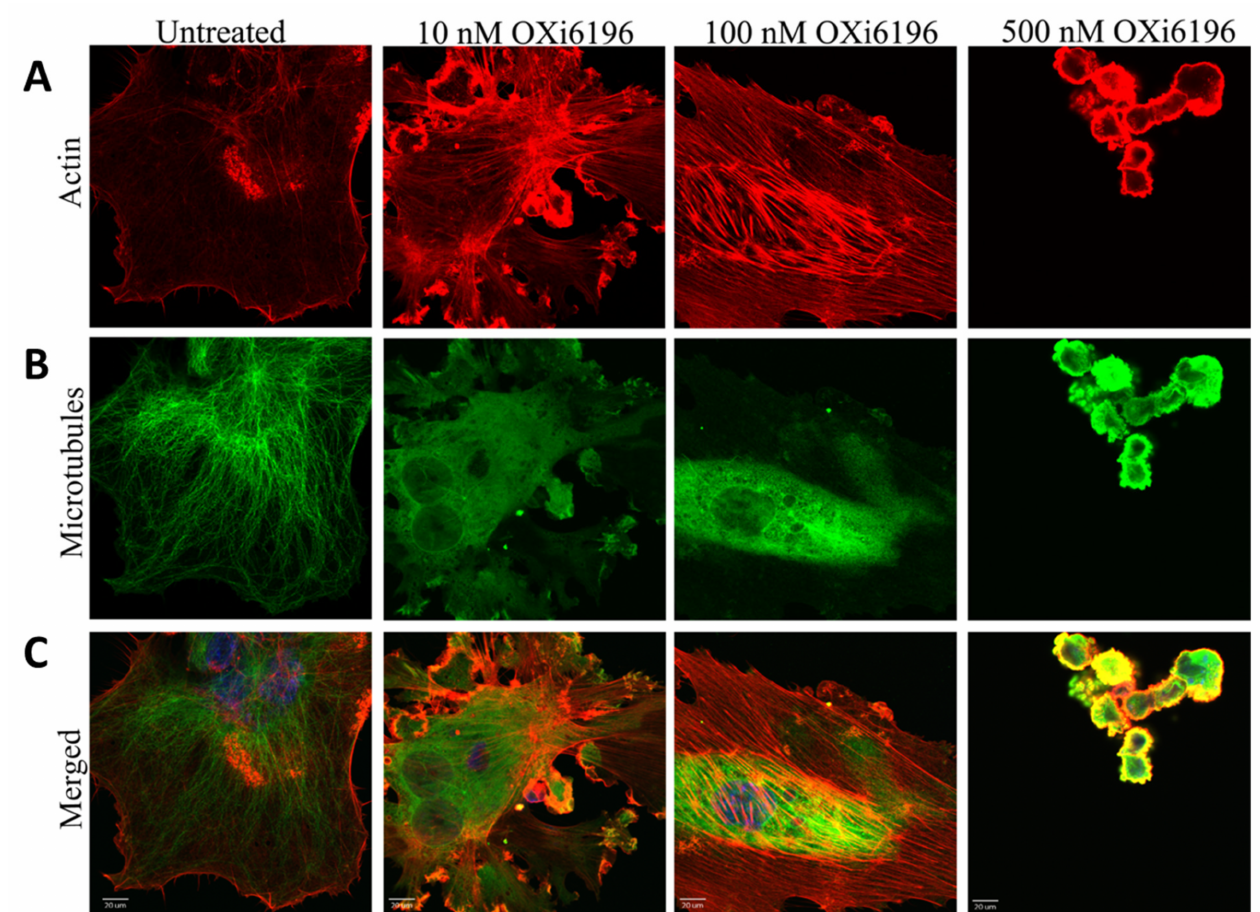
Figure 3. Confocal images of endothelial cells fixed and stained for actin and microtubules. Monolay- ers of rapidly growing HUVECs underwent concentration-dependent changes in the cell morphology with OXi6196 treatment (2 h) that demonstrated an initial loss of the microtubule structure and in- creased bundling of filamentous actin into stress fibers. Many cells with two nuclei were observed. At higher concentrations (500 nM) cells had detached with remaining adherent cells rounded, condensed and showing multiple blebs. Representative confocal images for endothelial cells fixed and stained with ( A ) Alexa Fluor™ 594-conjugated phalloidin (red, actin), ( B ) anti- α -tubulin antibody (green, microtubules), ( C ) merged image. Bars, 20 µ